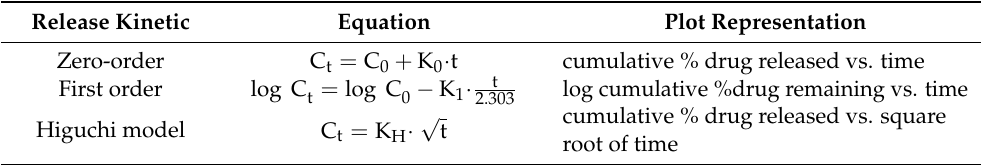
Table 1. Release kinetics models applied [47]. Release Kinetic Equation Plot